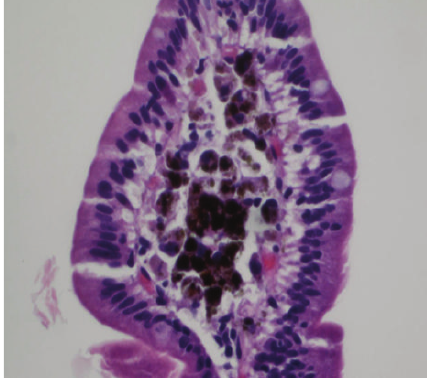
Figure 2: Histological examination of duodenal biopsy showing black pigmentation.